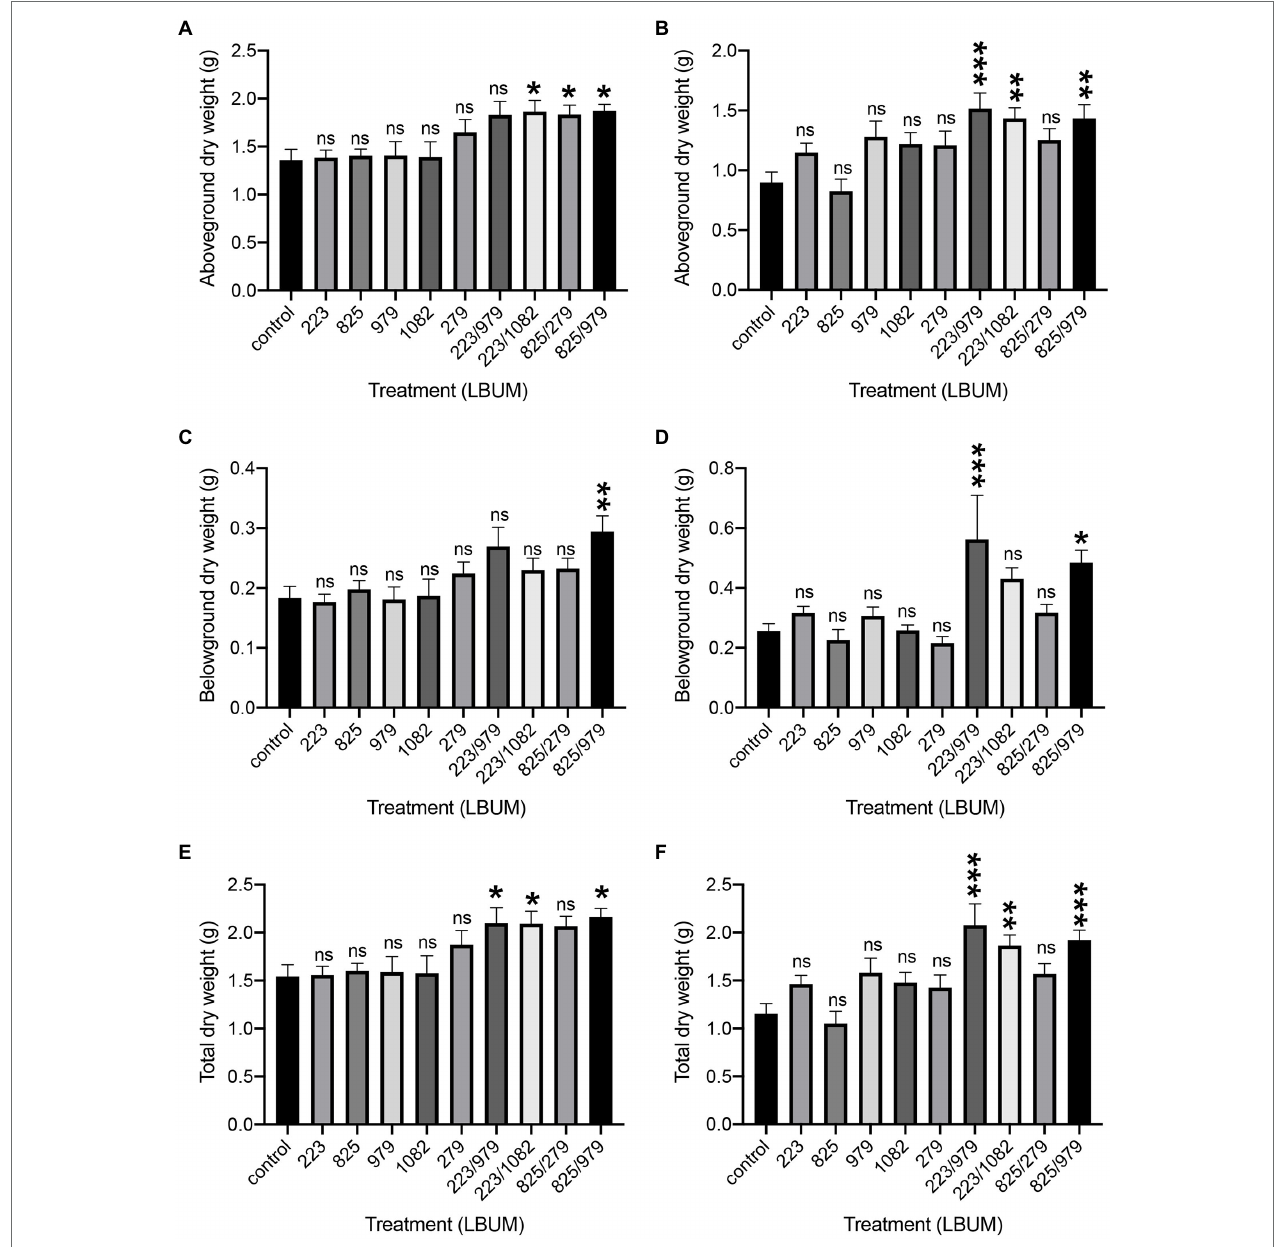
FIGURE 1 | Plant growth promotion of Cannabis sativa treated with Pseudomonas spp. and Bacillus spp. alone or in combination, grown in Promix and Canna coco substrates. Plant growth promotion above-ground (dry weight) in (A) Promix and (B) Canna coco. Plant growth promotion below-ground (dry weight) in (C) Promix and (D) Canna coco. Total dry weight in (E) Promix and (F) Canna coco. Statistical analysis: ANOVA (* p < 0.05, ** p < 0.01, *** p < 0.001, ns, not significant); mean dry weight and standard deviation of at least 12 replicates per treatment